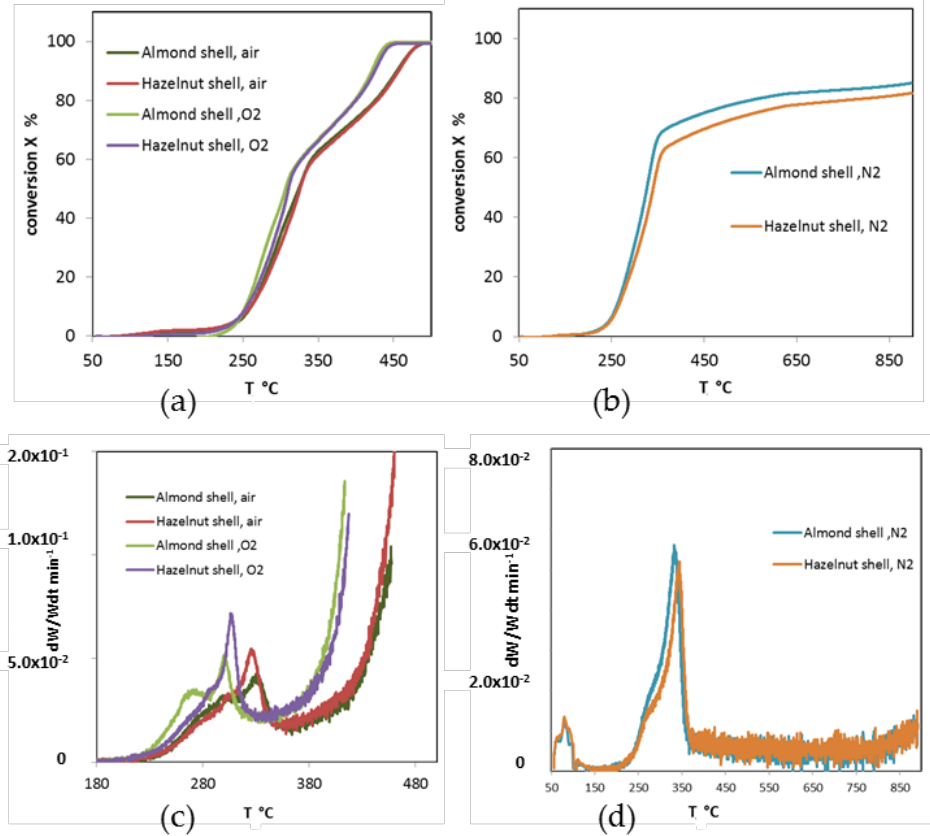
Figure 2. Thermogravimetric analysis of almond shells (M) and hazelnut shells (N): ( a ) Degree of conversion (X) vs. Temperature in air and O 2 ; ( b ) Degree of conversion (X) vs. Temperature in N 2 ; ( c ) Specific conversion rate in air and O 2 ; ( d ) Specific conversion (pyrolysis) rate in N 2 .